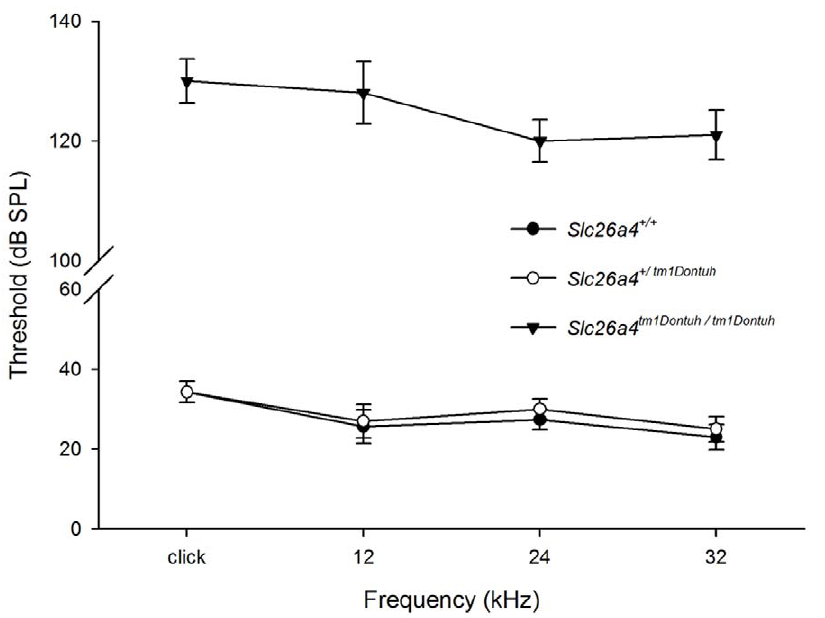
Figure 3. Audiological phenotypes of Slc26a4 tm1Dontuh/tm1Dontuh mice. All Slc26a4 tm1Dontuh/tm1Dontuh mice (n=15) revealed profound hearing loss ( . 120 dB SPL) according to ABR at all frequencies, whereas all Slc26a4 + /tm1Dontuh mice (n=15) and all Slc26a4 + / + mice (n=15) revealed normal hearing.